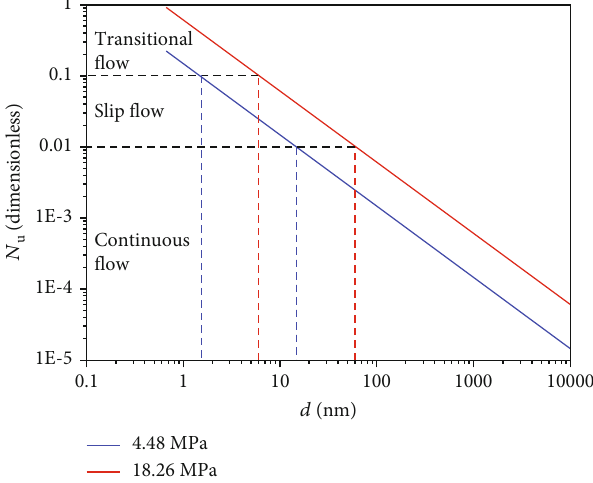
Figure 5: The distribution of K conditions at the beginning and end of the